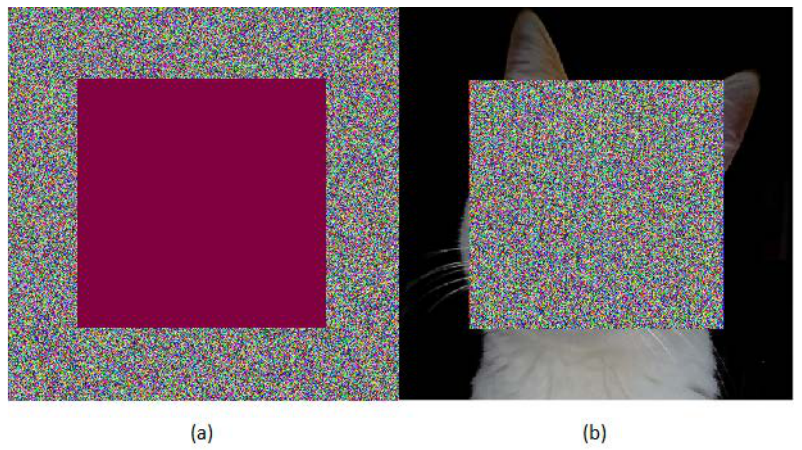
Figure 5. Image ( a ) is the Vicky cat image ciphered of Figure 1c using AES–CBC with 40% occlusion damage and ( b ) is the deciphered